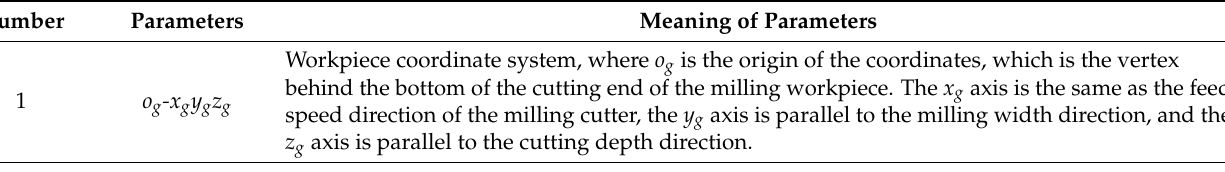
Table 1. Meaning of milling cutter structure and cutting state